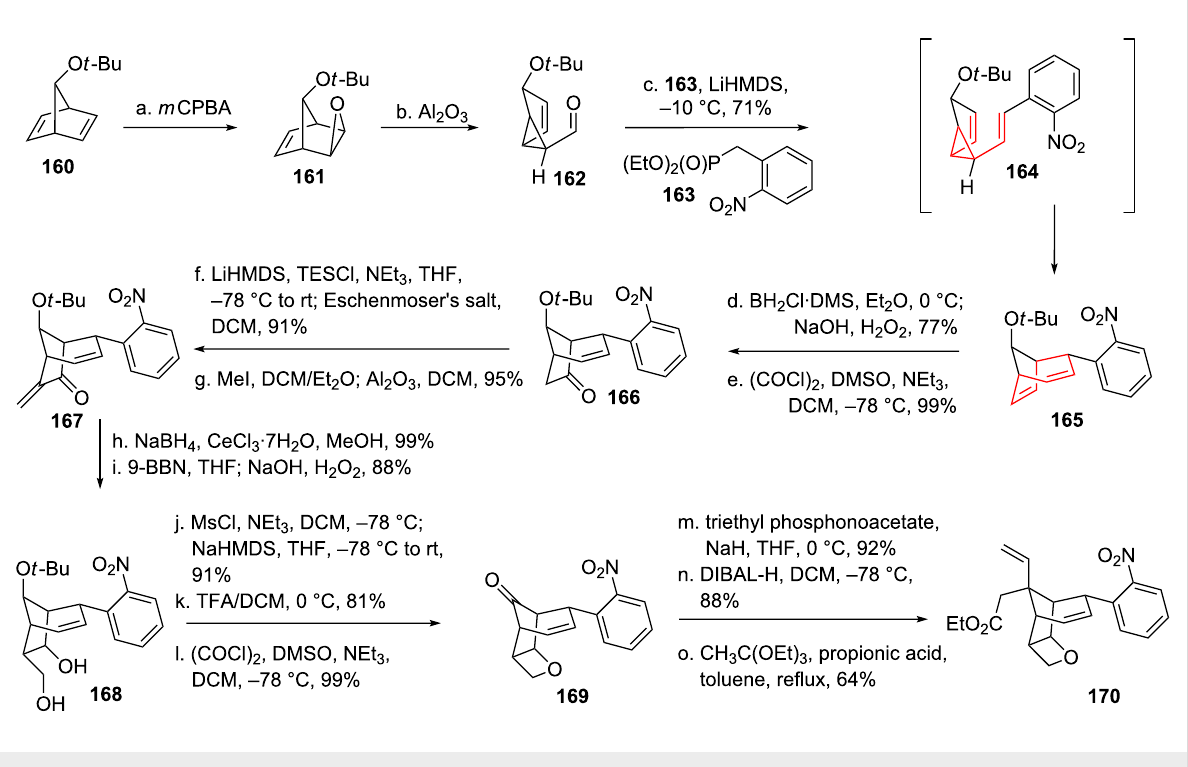
Scheme 20: Danishefsky’s total synthesis of gelsemine, part